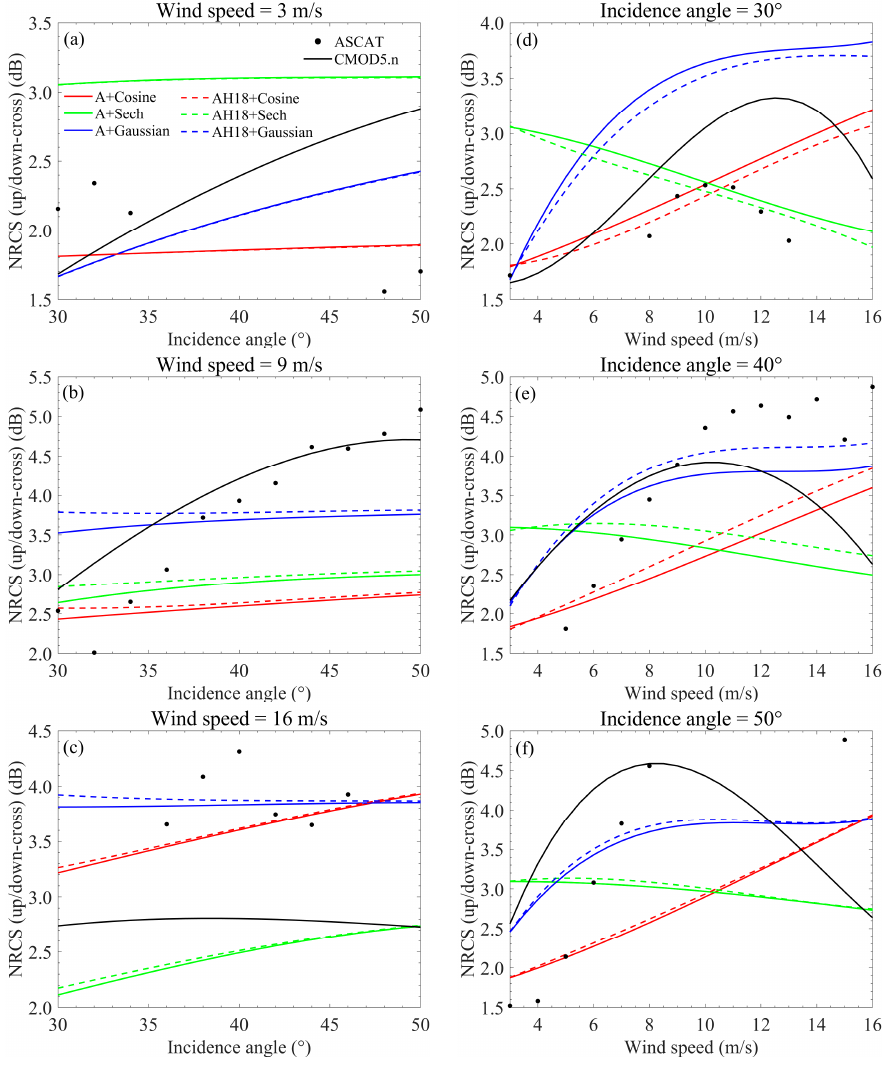
Figure 11. Upwind–crosswind anisotropy predicted by the modified TSM with different directional wave spectra input, and their comparisons with the ASCAT data and CMOD5.n. ( a – c ) Results plotted as functions of incidence angle for wind speeds of 3 m/s, 9 m/s, and 16 m/s. ( d – f ) Results plotted as functions of wind speed for incidence angles of 30°, 40°, and 50°. Table 3. The ζ values at different wind speeds under incidence angle of 30 ◦ .